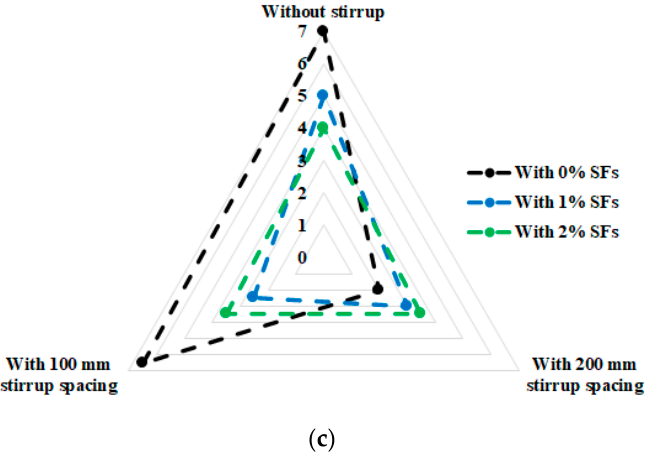
Figure 20. Effect of SFs on the maximum crack widths for ( a ) 0% RCA, ( b ) 50% RCA and ( c ) 100% RCA.